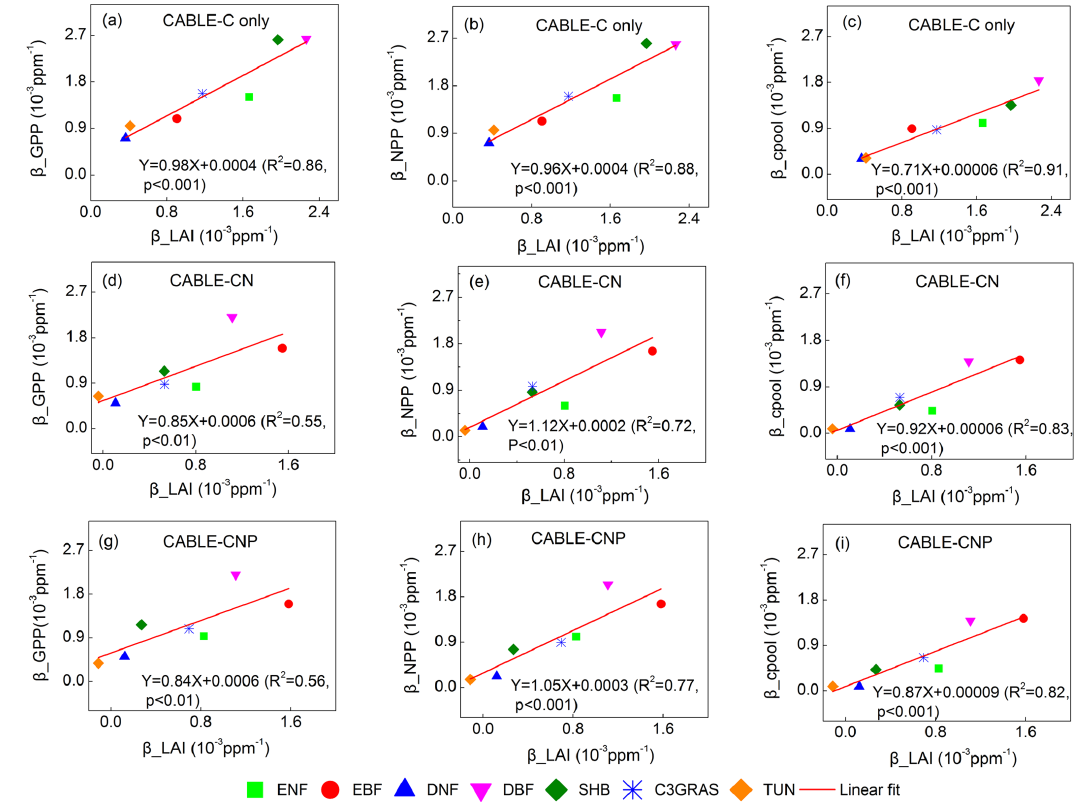
Figure 4. Correlations between β GPP and β LAI , β NPP and β LAI , and β cpool and β LAI at the year 2023 across C 3 PFTs from CABLE-C- only (a–c) , CABLE-CN (d–f) and CABLE-CNP (g–i) simulations. β GPP , β NPP and β cpool all have significant linear correlations with β LAI in all simulations. Abbreviations and symbols are the same as Fig.